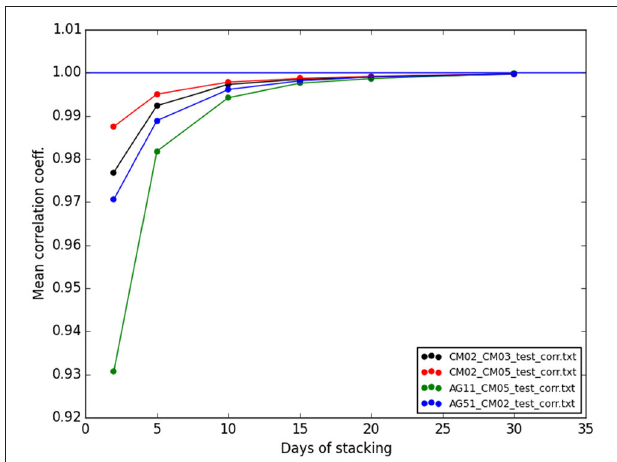
FIGURE 6 | Test to select the optimal number of days of stacking. Mean correlation coefficient between CC current and reference for four sample couples as a function of the number of stacking